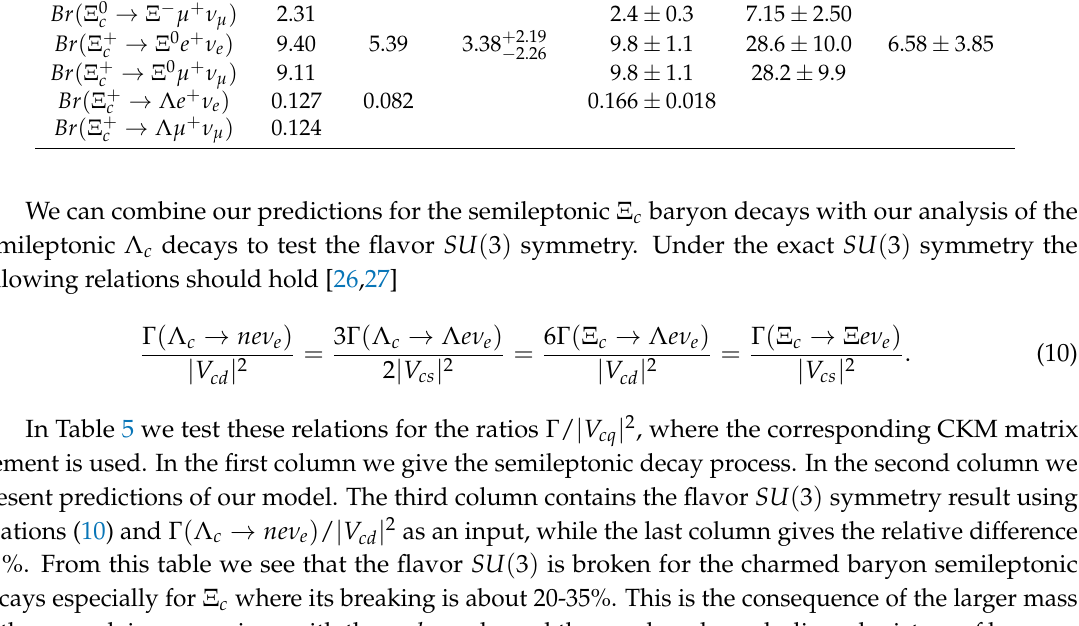
Table 5. Predictions for the ratios Γ / Decay Our Exact